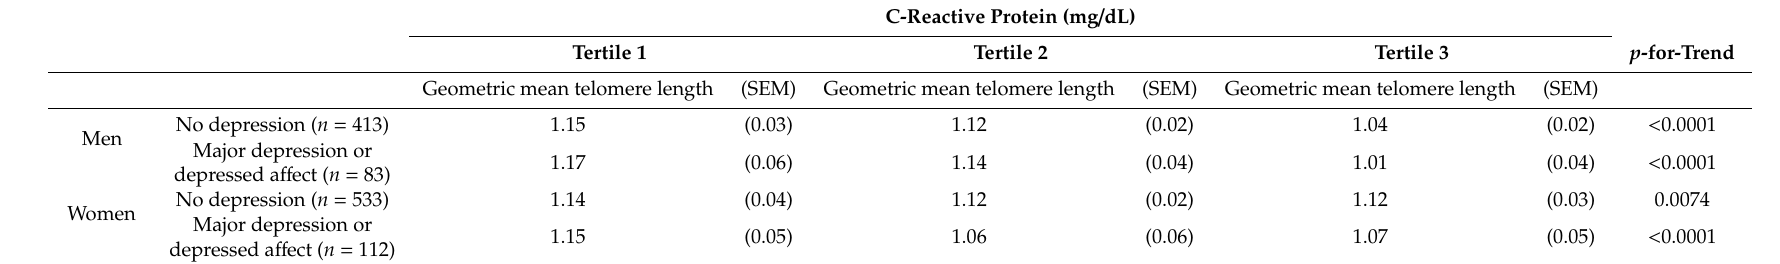
Table 2. Geometric means of telomere lengths stratified by depression status and tertiles of C-reactive protein level by